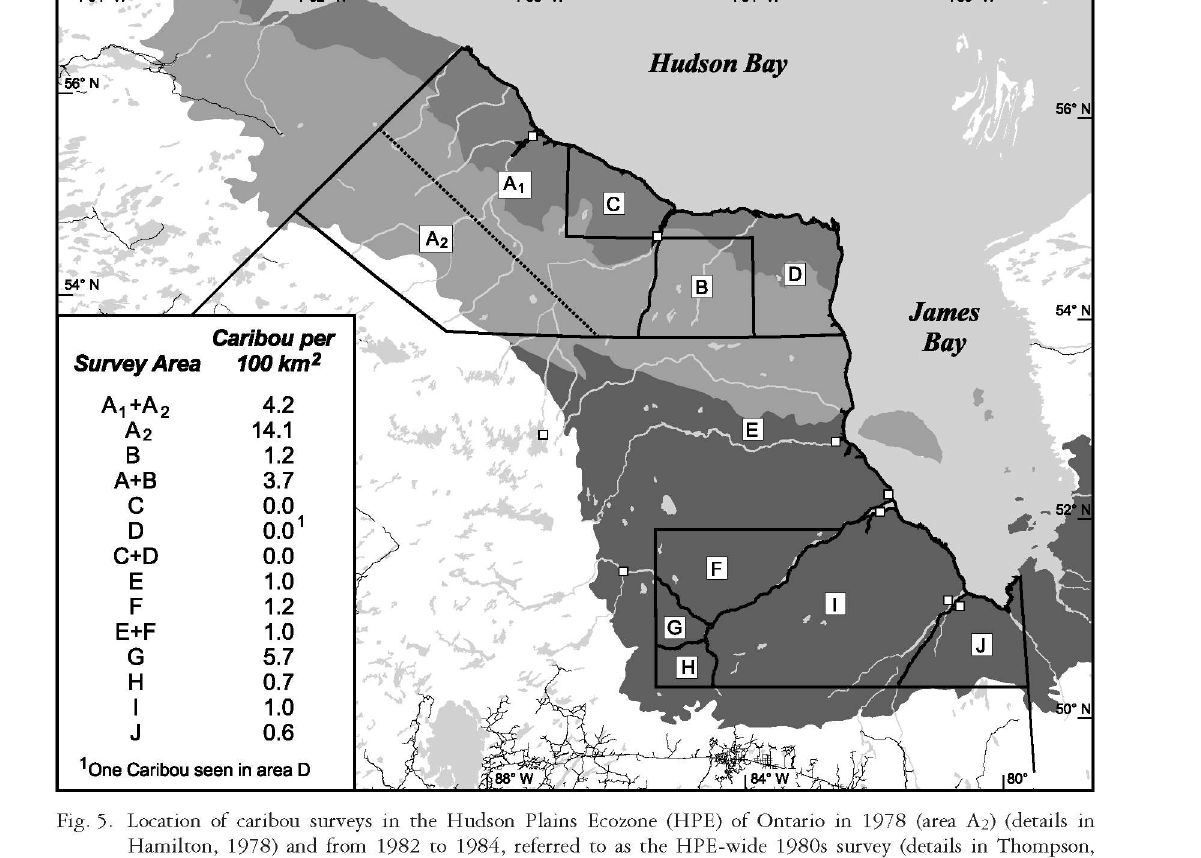
Fig. 5. Location of caribou surveys in the Hudson Plains Ecozone (HPE) of Ontario in 1978 (area A 2) (details in Hamilton, 1978) and from 1982 to 1984, referred to as the HPE-wide 1980s survey (details in Thompson, 1986). Caribou counted on transects are expressed as caribou per 100 km 2 of transect area.